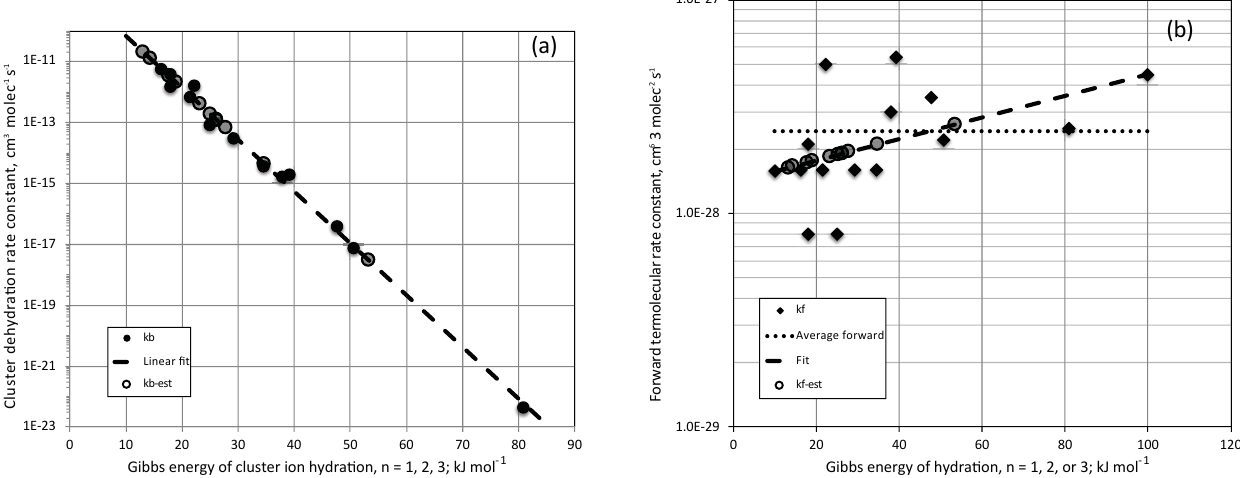
Figure 1. Ion cluster dehydration (a) and hydration (b) reaction rate coefficients plotted as a function of the Gibbs reaction energy ( G o rxn ) for I − , O − , O − , CO − , HO − , NO − , NO − and NO − ions for n = 1–3 water molecules. Solid circles are reported rate coefficients from the 2 3 3 2 3 literature (see text) and open circles are estimates based upon linear regression of ln( k dehydration ) versus G o rxn or k hydration = k dehydratio n × K eq